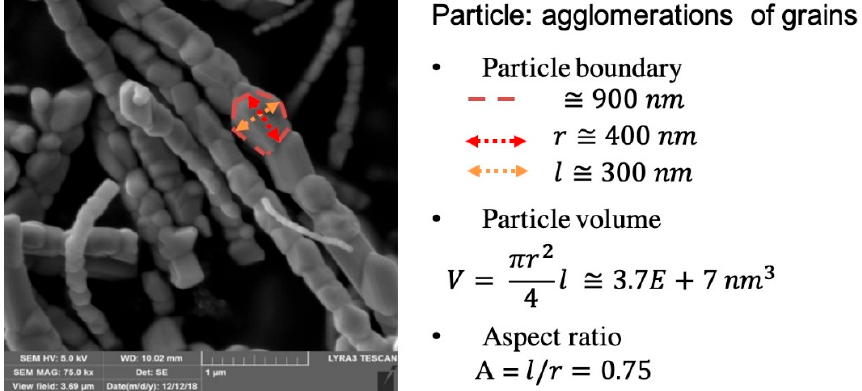
Figure 1. Schematic for particle size measurement.